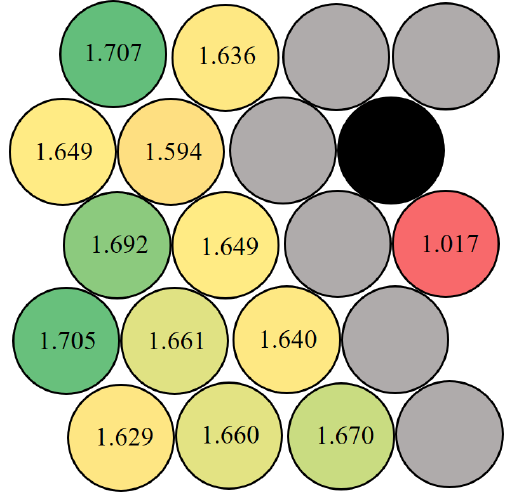
Figure 3. Results of the single cell measurement. Capacity in Ah.